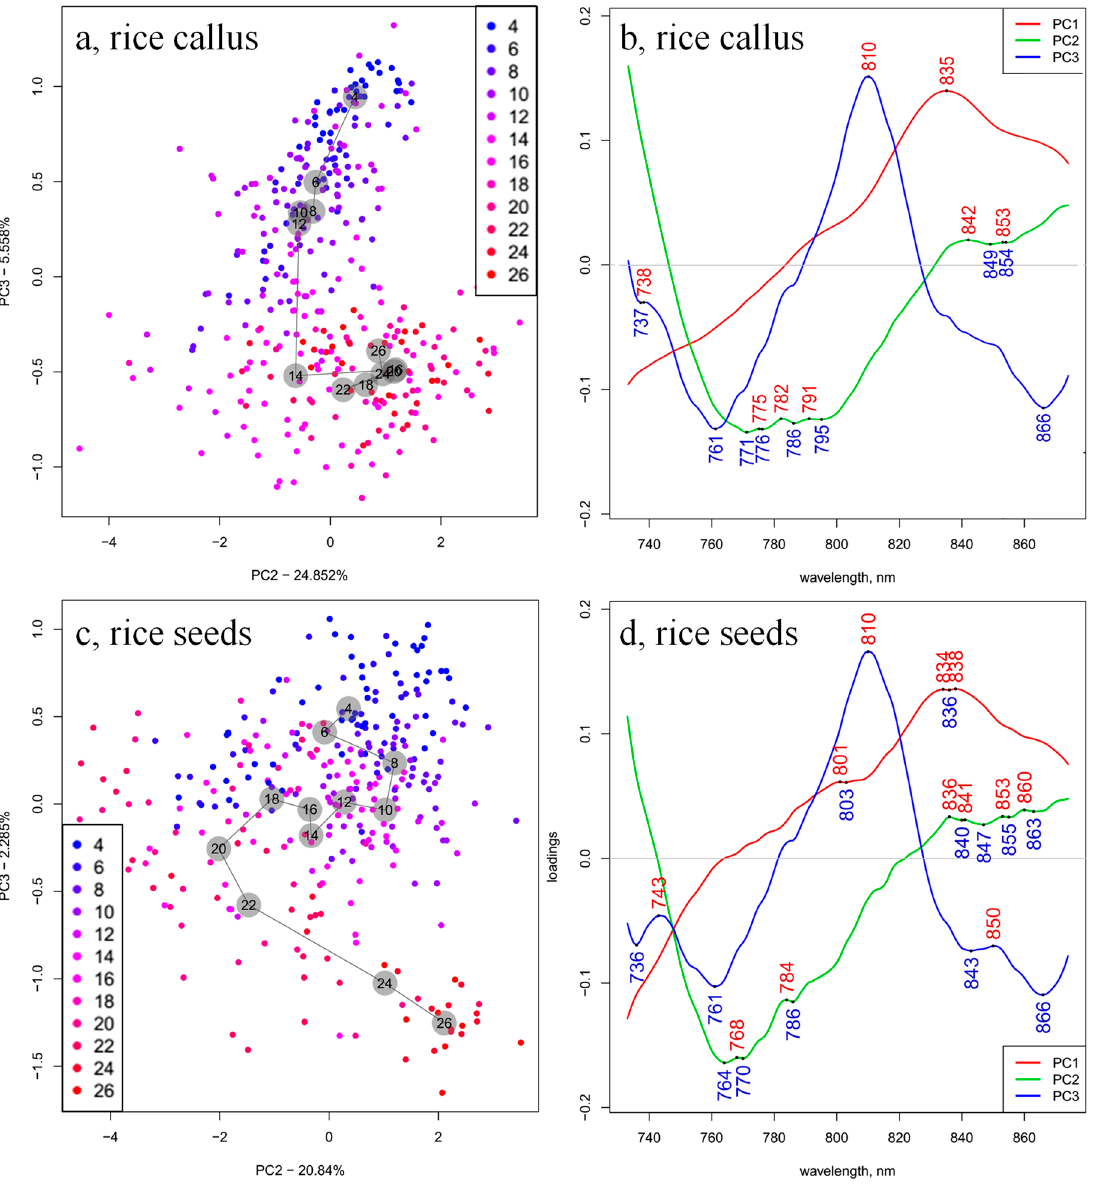
Figure 3. PCA scores (PC1 and PC3, or PC2 and PC3) of ( a ) 28 callus samples and ( c ) 28 rice seedlings, and the loadings of ( b ) 28 callus samples and ( d ) 28 rice seedlings calculated on the smoothed, SNV- and linear detrend-corrected transmittance spectra in the spectral range between 730 and 870 nm (numbers in the gray circles show the group center for the different days of